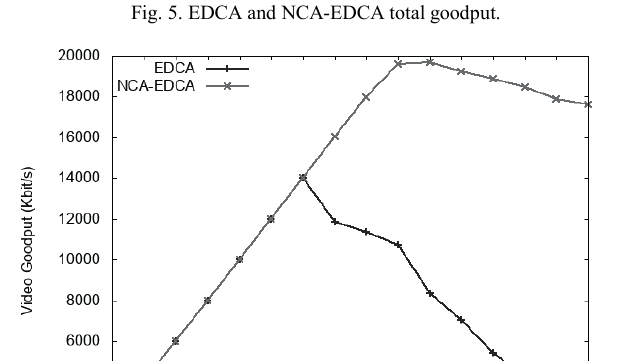
Fig. 5. EDCA and NCA-EDCA total goodput.